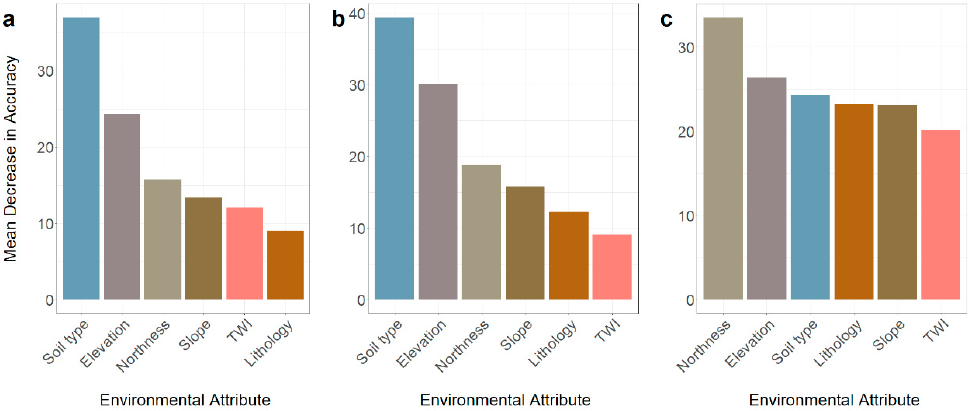
Figure 7. Variable importance according to mean decrease in accuracy of the six environmental variables for each time-series clustering map: ( a ) trend; ( b ) seasonality; and ( c ) remainder. The analysis was conducted using a random forest classifier. TWI stands for topographic wetness index.